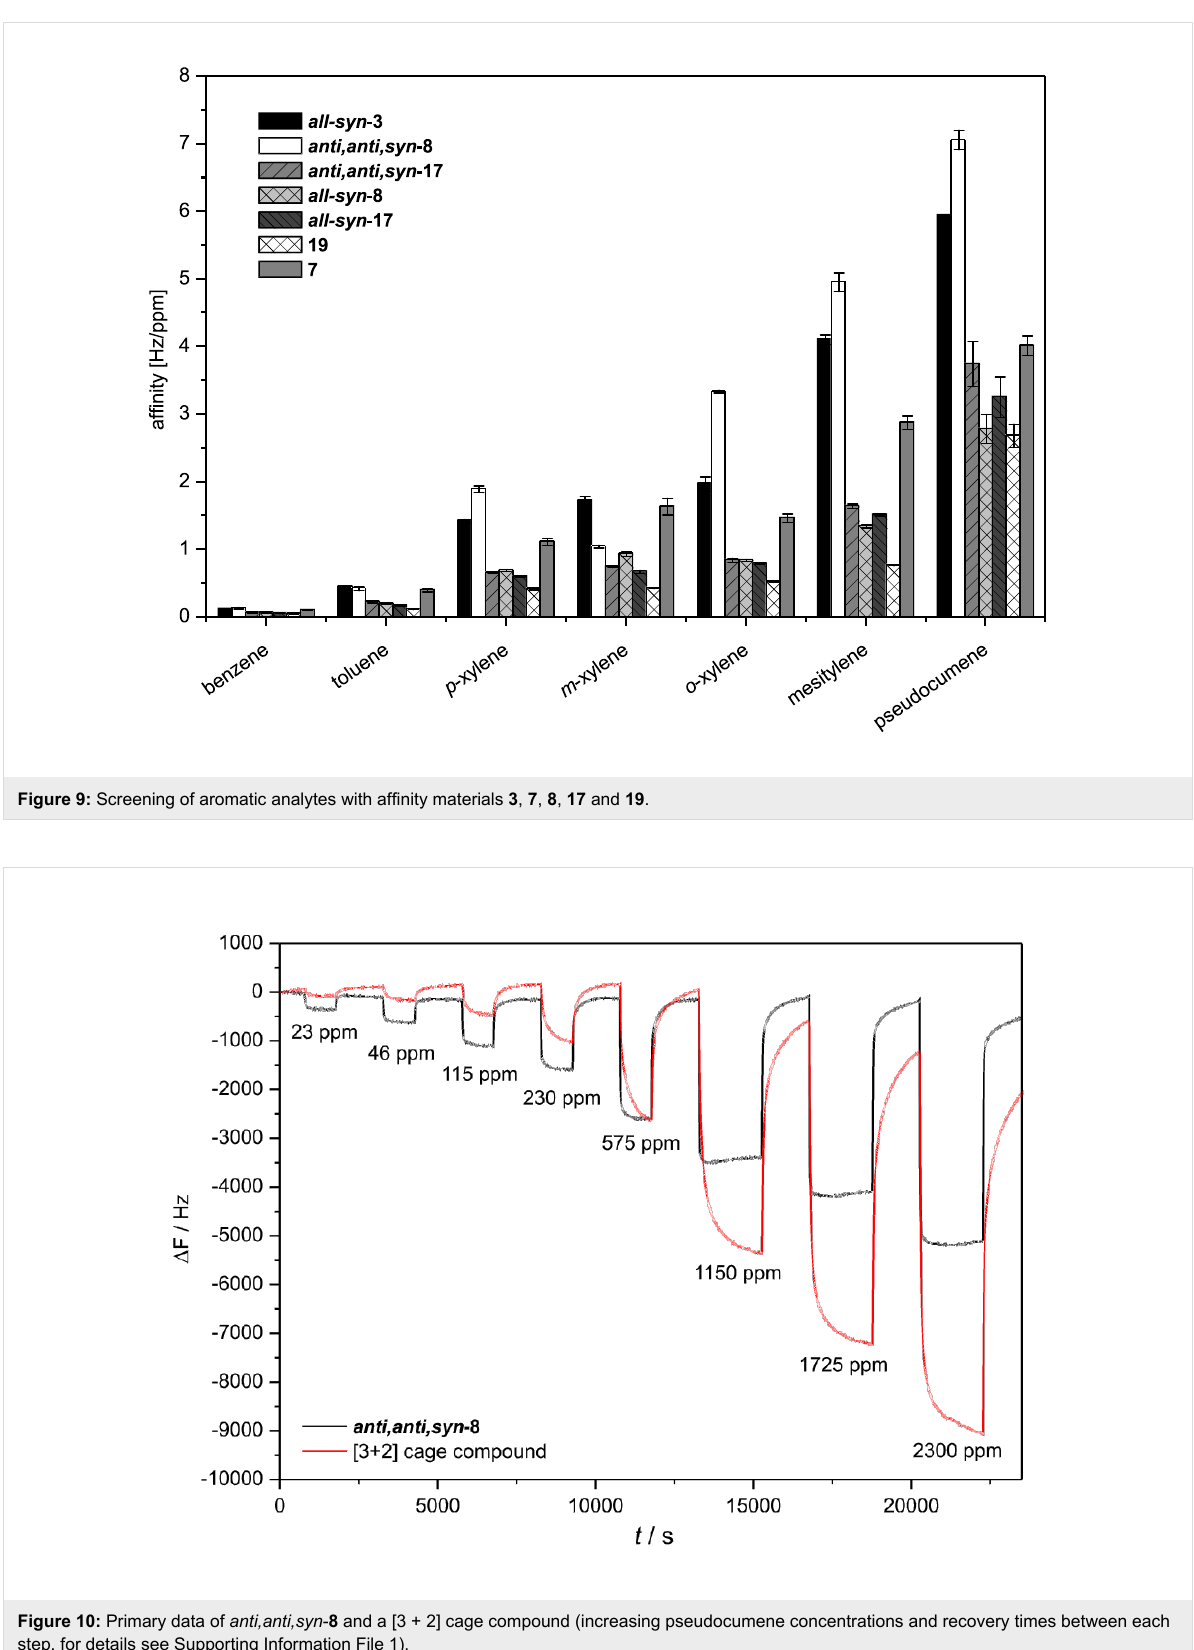
Figure 10: Primary data of anti,anti,syn - 8 and a [3 + 2] cage compound (increasing pseudocumene concentrations and recovery times between each step, for details see Supporting Information File